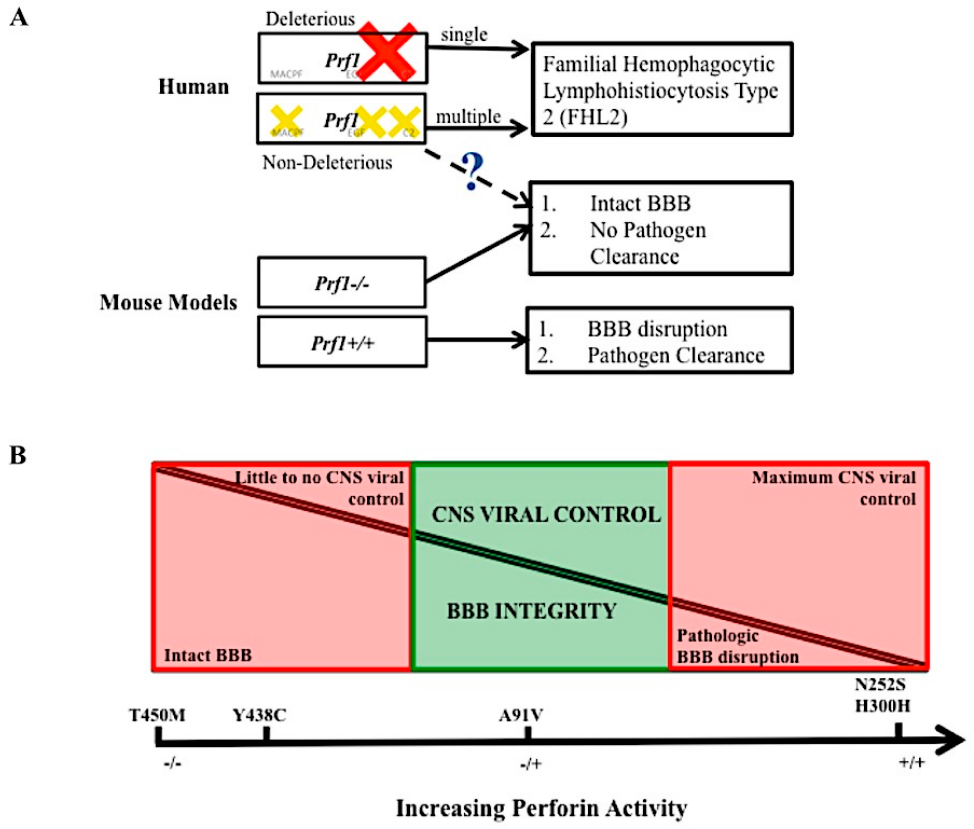
Figure 5. The balance of perforin expression may be advantageous to an individual’s fitness. Hypothetical model of perforin’s contribution to pathogen clearance and vascular permeability. Loss of perforin activity in the human due to single deleterious mutation ( red cross ) or multiple, compounding mutations ( yellow crosses ) leads to disease FHL 2. In the mouse model, mice lacking perforin cannot clear virus in the CNS but do not experience BBB disruption. Perforin competent mice can clear virus in the CNS but experience lethal BBB disruption. The dashed line and question mark indicate a level of perforin, found in the human population that may mediate BBB disruption but still allow for CNS pathogen control ( A ). At full perforin activity, CNS viral control is possible, however there is pathologic BBB disruption. At no perforin expression, pathologic BBB disruption is not present, but there is little of CNS viral infection. Non deleterious perforin SNVs that decrease but do not abolish perforin’s activity may provide a balance between these two pathologies ( B ). The five SNVs listed are purely there as a frame of reference, we do not conclude that these exact polymorphisms play a role in this balance.